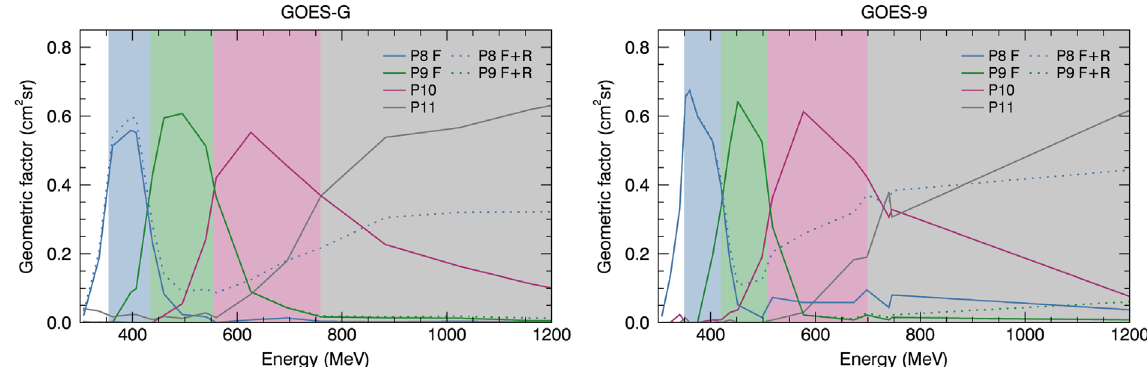
Fig. A.1. Energy dependence of geometric factor of HEPAD channels P8 – P11 for GOES-G (left) and GOES-9 (right). The solid lines show the geometric factor for front entry particles, and the dashed lines show the geometric factor for both front and rear entry particles (rear entry only signi fi cant for P8 and P9). The background colors show the nominal energy ranges of